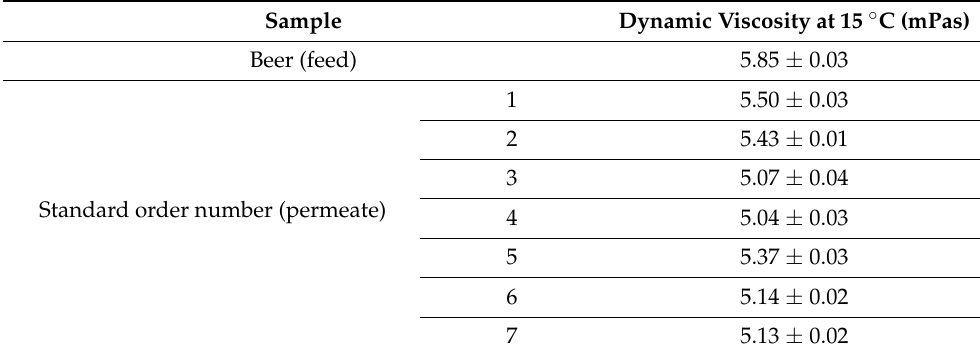
Table 6. Dynamic viscosity values of beer and permeate samples at the separation temperature.